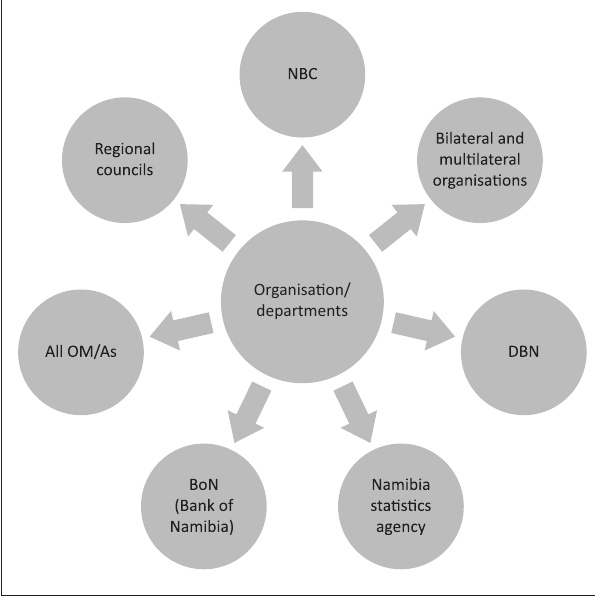
FIGURE 4: Department and other external organisations with which collaboration take place.